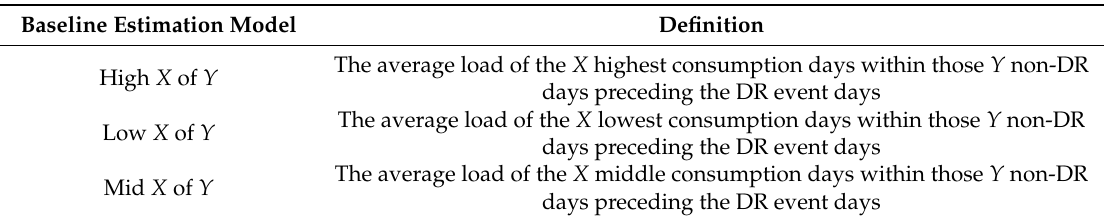
Table 2. Summary of the averaging